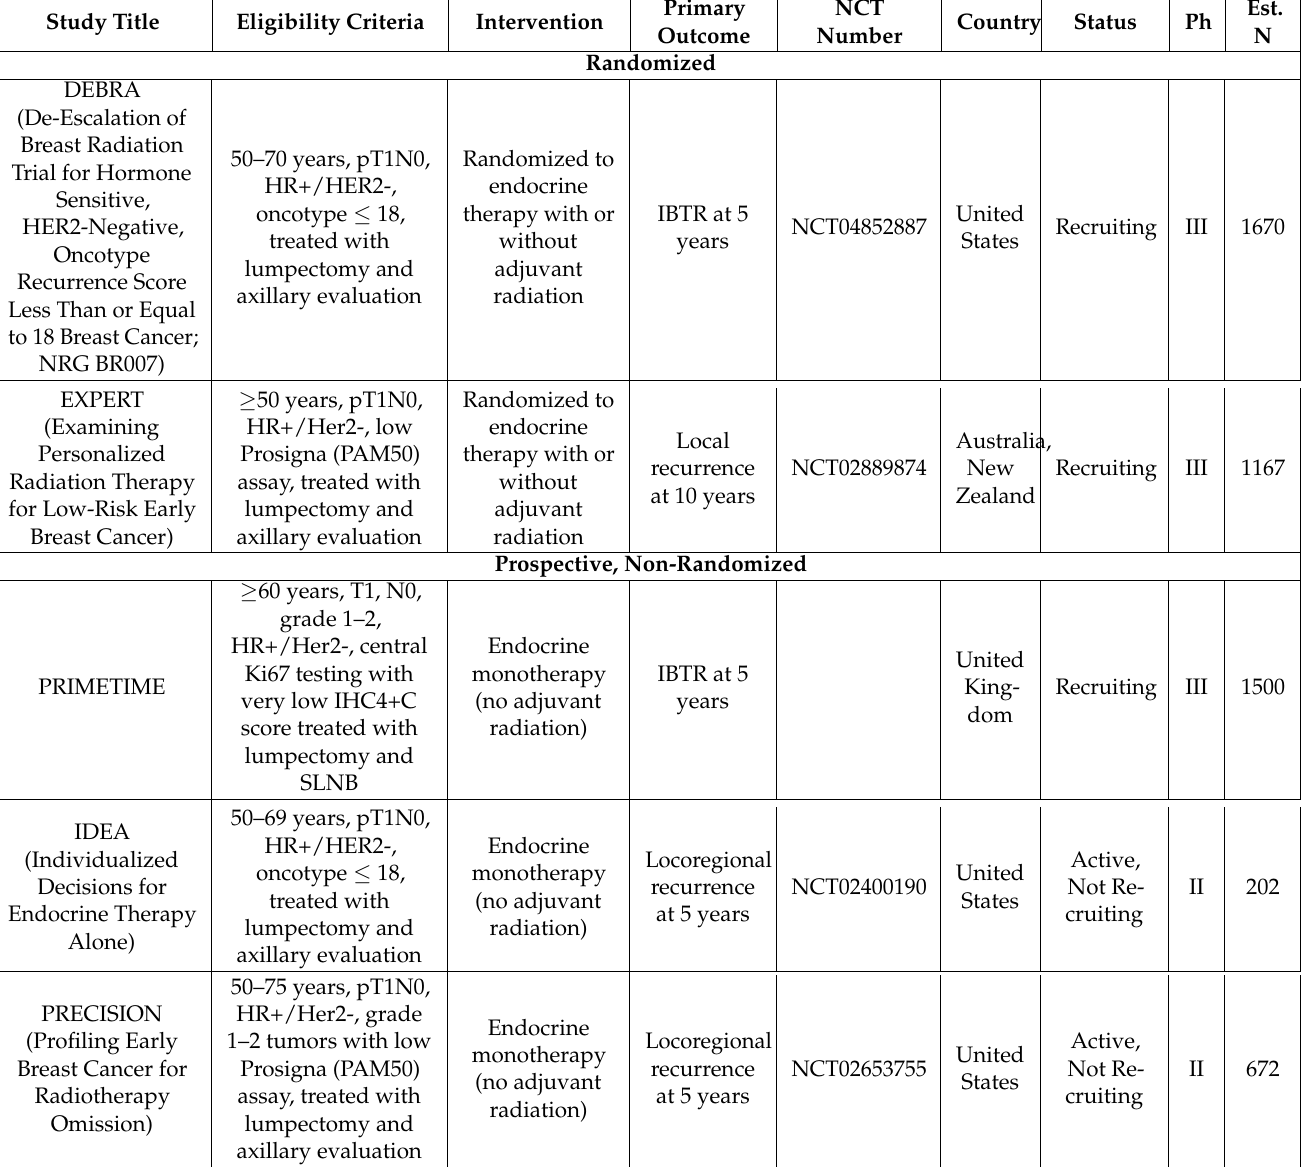
Table 1. Select ongoing clinical trials of omission of radiation in favor of endocrine therapy alone for women with early-stage hormone sensitive breast cancers following breast conserving